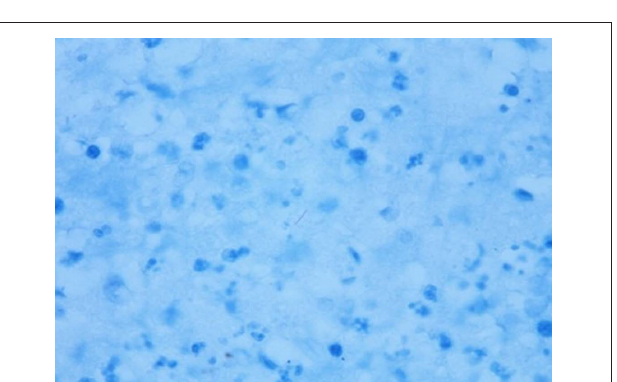
Figure 4 | Hematoxylin and